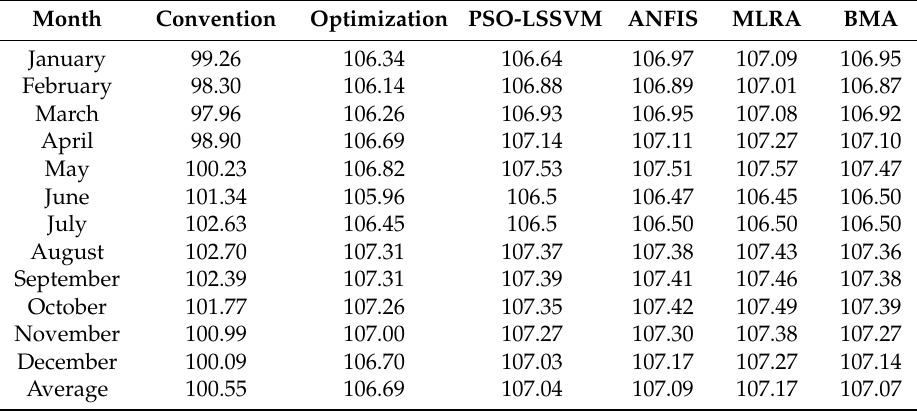
Table 4. Average monthly water level of the hydropower reservoir simulated using the optimal/conventional operation, PSO-LSSVM, ANFIS, MLRA, and BMA models.